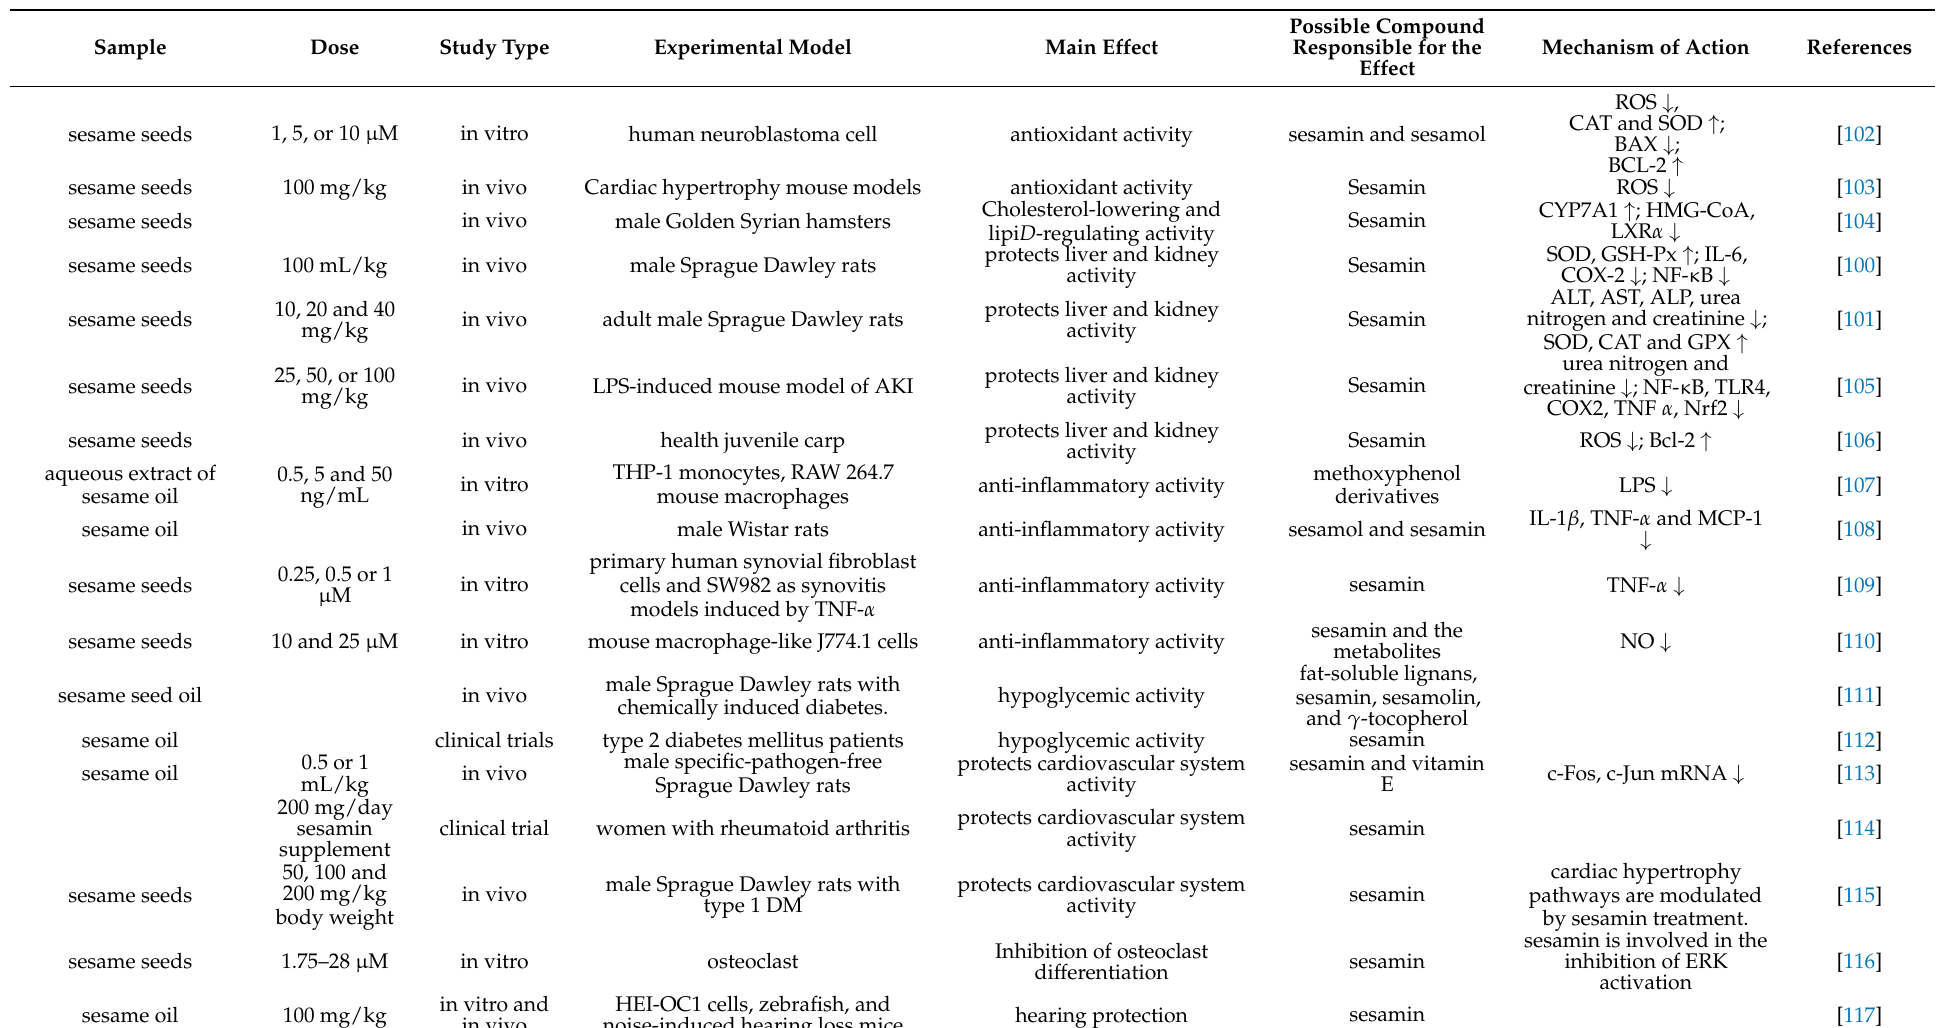
Table 4. Health Functions and Related Mechanisms of